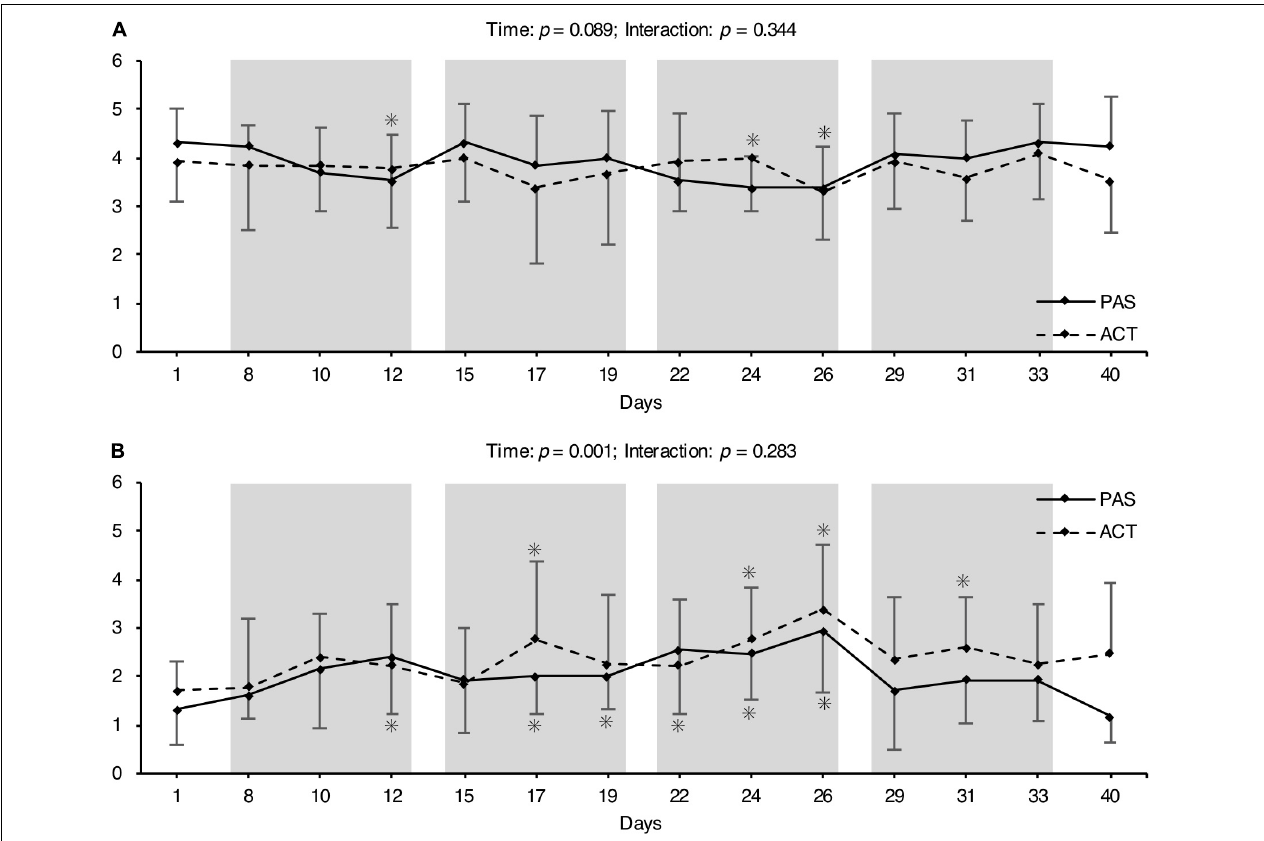
FIGURE 3 | Mean ( ± SD) of overall recovery (A) and overall stress (B) before, during, and after the 4-week HIIT period. The gray columns mark the individual training weeks. ∗ Significant difference compared to pre ( p <